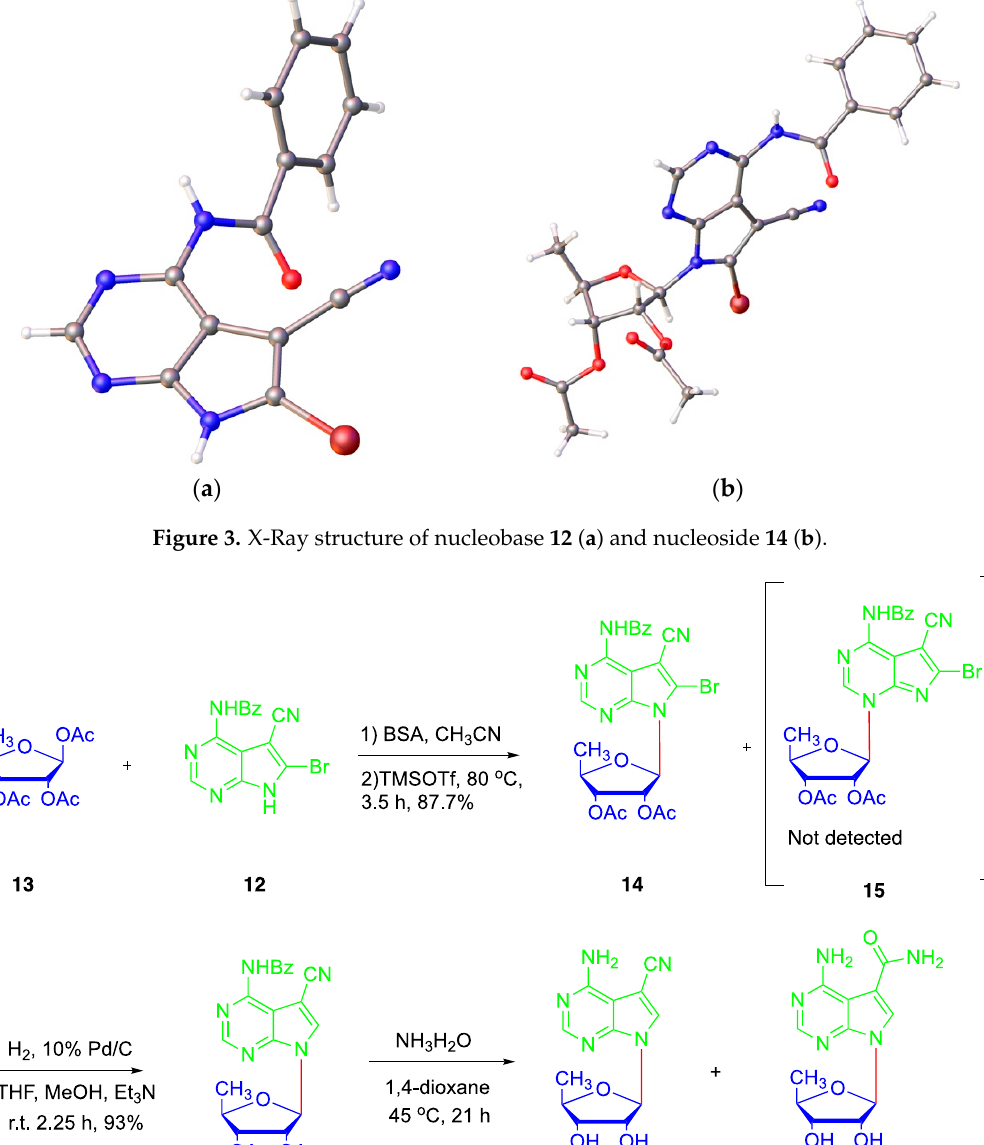
( b ) Figure 3. X-Ray structure of nucleobase 12 and nucleoside 14 . A variety of other conditions were tried with no improvement. Looking back the X-ray structures of nucleobase 12 and nucleoside 14 , it was obvious that the carbonyl of the N -6 benzoyl was close and syn to the C-7 nitrile group (Figure 3) [39]. Therefore, the nitrile group of nucleoside 16 could be activated by the electron-withdrawing benzoyl group, which makes the nitrile group susceptible to attack by ammonia. Luckily, 5 ′ -deoxytoyocamycin ( 3 ) and 5 ′ -deoxysangivamycin ( 4 ) were both targets, and they could be conveniently separated by chromatography. In the end, 5 ′ - deoxytoyocamycin ( 3 ) and 5 ′ -deoxysangivamycin ( 4 ) were obtained in 67% and 24% yield, respectively, after removing all the benzoyl protecting groups with ammonia in dioxane. All the spectra of 5 ′ -deoxytoyocamycin ( 3 ) were in accordance with those of the naturally occurring product. Because different solvents were used in the original NMR determination of naturally occurring 5 ′ -